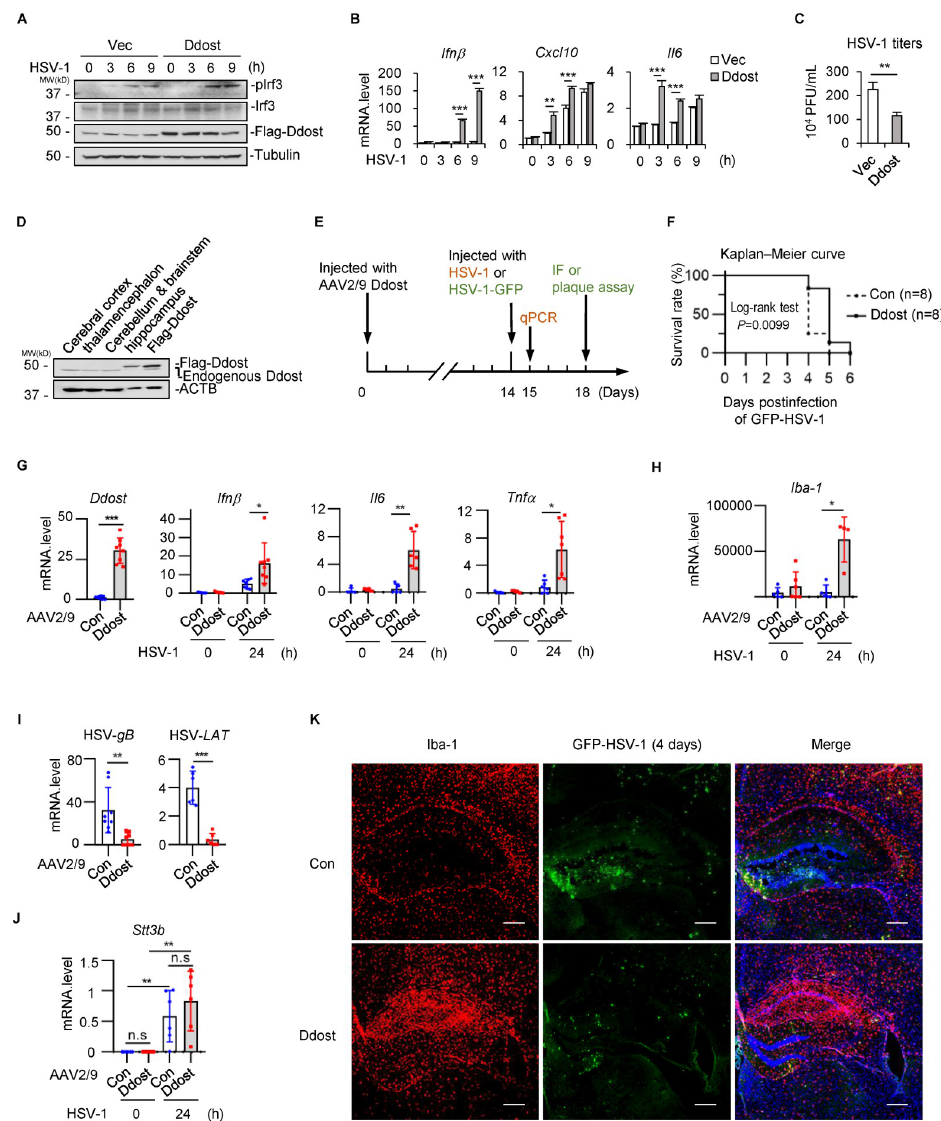
Fig 6. Ddost overexpression strengthens antiviral immune responses of mice suffering from HSE. (A, B) Stable mouse Neuro-2a (N2a) cells expressing Flag-Ddost and control N2a cells expressing empty vector (Vec) were prepared by lentiviral transduction and puromycin (1 μ g/mL) selection for 10 days. HSV-1 (MOI = 4) was added to the cells for the indicated time, and cell lysates were collected for immunoblotting analysis (A) or qPCR (B). Data displayed are the mean ± SD (n = 3). �� P < 0.01, ��� P < 0.001 (unpaired t test). (C) Stably expressing Flag-Ddost N2a cells and control cells (Vec) were infected with HSV-1 (MOI = 2) for 24 hours. HSV-1 replication was determined by plaque assays. Data displayed are the mean ± SD (n = 3). �� P < 0.01 (unpaired t test). (D) The expression of ectopic and endogenous Ddost in different brain regions 14 days after AAV-Ddost injection was determined by immunoblotting analysis. (E) Schematic diagram of AAV stereotactic injection and HSV-1 delivery into the mouse hippocampus region. (F) Ddost- overexpressing and control mice (n = 8 for each group) were intracranially injected with GFP-HSV-1 (2 × 10 5 PFU per mouse). Mouse survival was monitored, and the survival rates were calculated and presented as Kaplan–Meier curves. (G-J) Ddost-overexpressing mice were injected with HSV-1 (3 × 10 4 PFU per mouse) for 24 hours. The hippocampus was separated and analyzed by qPCR for the indicated genes. The results were normalized to Gapdh . Data displayed are the mean ± SD (each dot represents the result from one mouse). � P < 0.05, �� P < 0.01, ��� P < 0.001. (K) Ddost- overexpressing or control mice were injected with GFP-HSV-1 (3 × 10 4 PFU per mouse) for 4 days (n = 5 for each group). Frozen sections (10 μ m) of the hippocampus were stained with anti-Iba-1 antibody and Cy3-labeled secondary antibody. Representative confocal images are shown. Scale bar, 200 μ